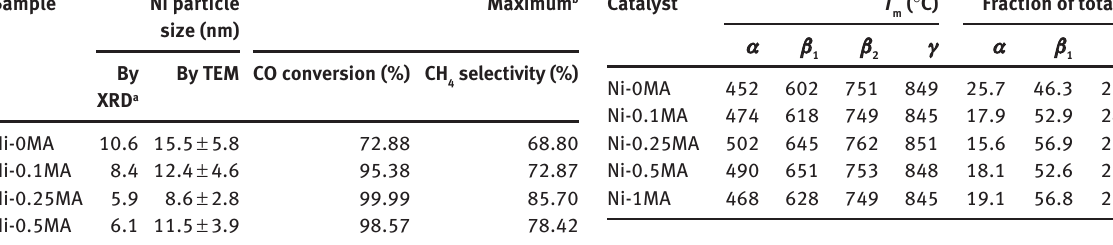
Table 2: Physical parameters of reduced catalysts. Sample